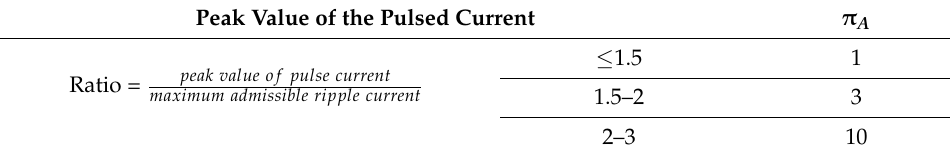
Table A1. Standard’s recommendation for parameter π A .